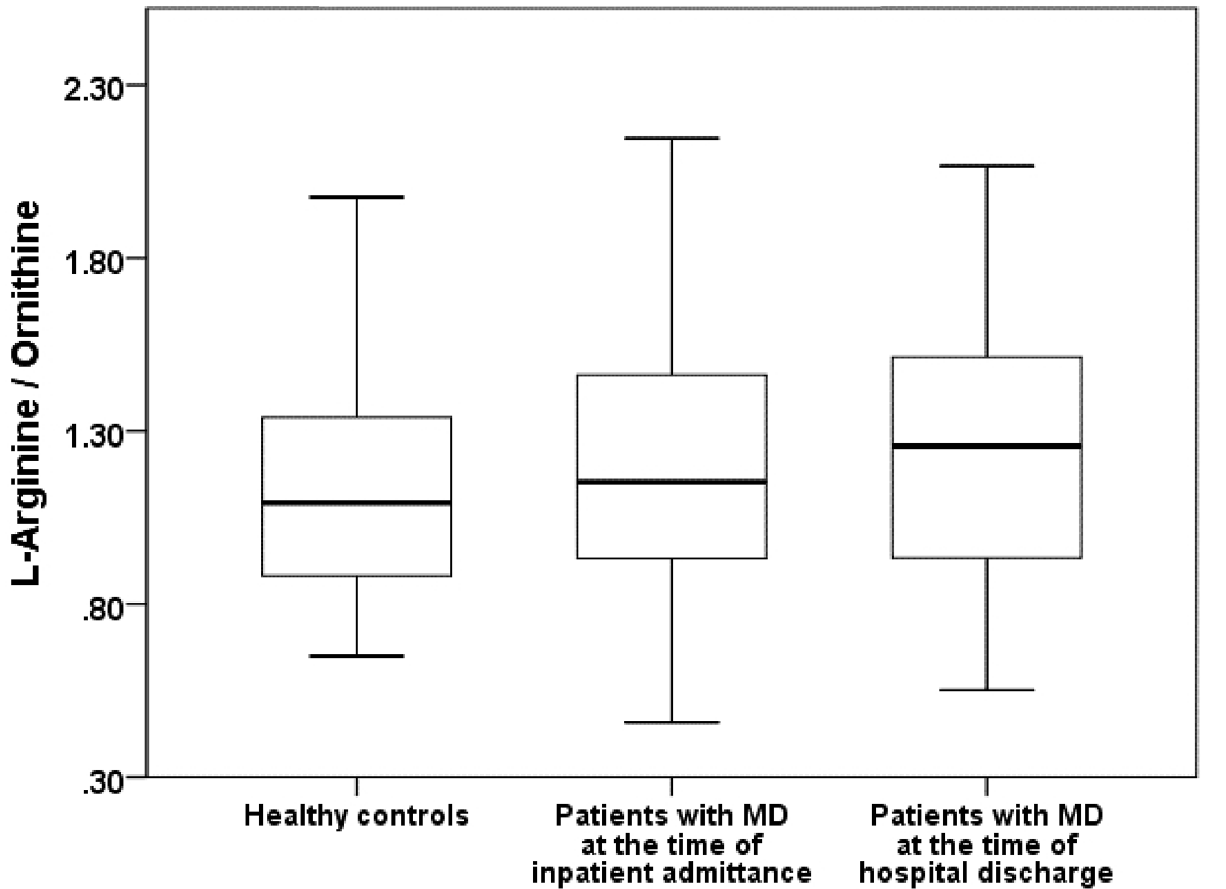
Fig 2. Comparison of the arginase activity ratio between healthy contols and patients with major depression (MD).